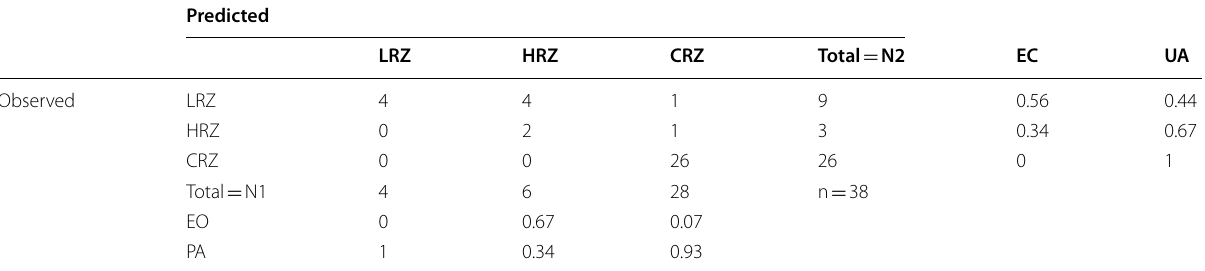
Table 1 Error matrix for validation of projected distribution area of Lantana Camara under different